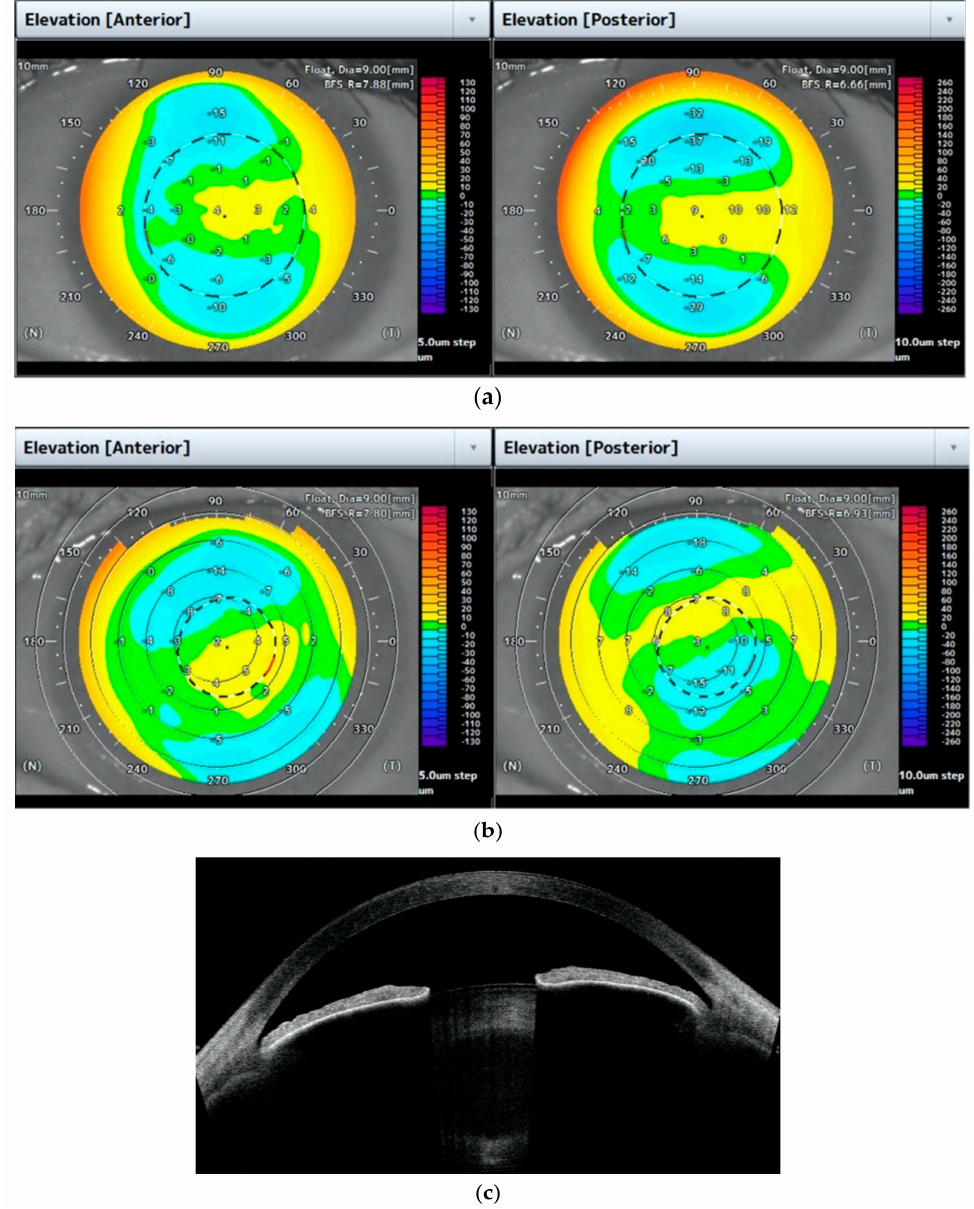
Figure 1. Anterior and posterior elevation maps of FECD and control eyes. Corneal and lens mor- phology assessment. ( a ) Maps of the left eye, representative of the control group. The maps show the typical characteristic pattern in which the apex is depicted in a warm colors above the Best Fit Sphere (BFS) with a slightly elevated isthmus which joined the central cornea from the temporal periphery. The maximum range between negative and positive values was within 15 and 27 µ m in 3 and 5